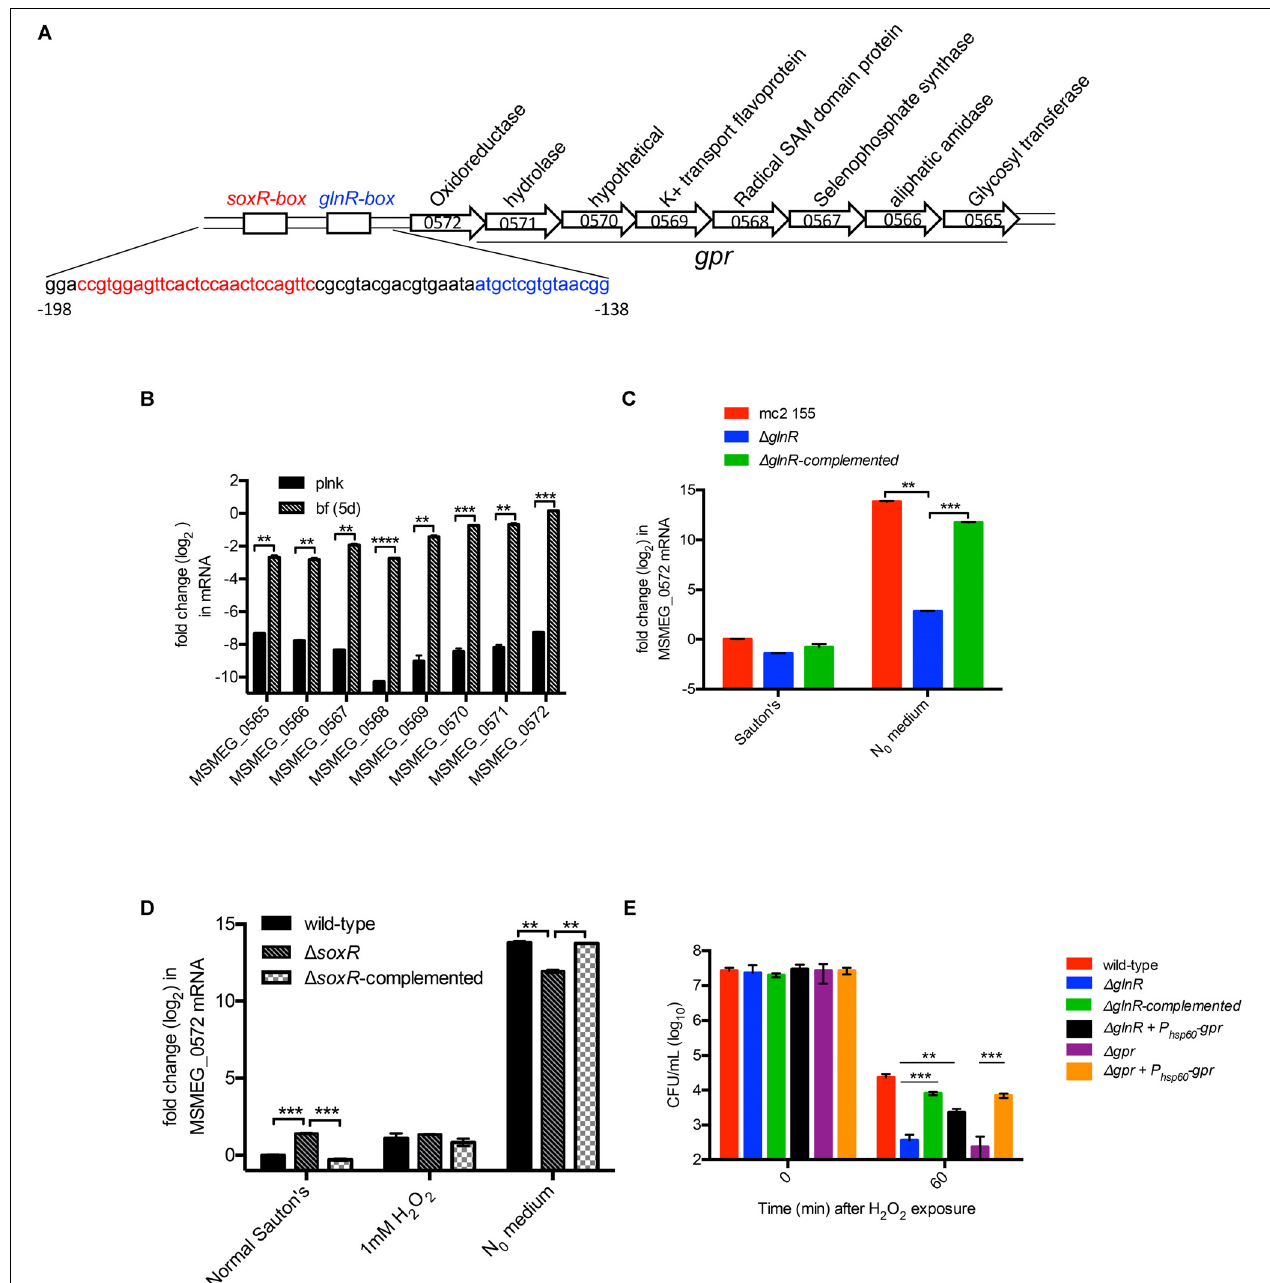
FIGURE 3 | GlnR-dependent peroxide resistance in M. smegmatis results from activation of a cluster comprising of eight genes (MSMEG_0565 to 0572), called gpr . (A) Schematic representation of gpr and the upstream GlnR and SoxR-binding regions, called GlnR -box and SoxR -box, respectively. Nucleotide sequence of the two regions are indicated below in their corresponding color codes. (B) Expression of each of the eight genes in gpr cluster in logarithmic phase (OD 0.3) planktonic culture and in 6-day biofilms, both cultured in Sauton’s medium. Transcripts were normalized with SigA transcripts. (C) GlnR-dependent induced expression of gpr cluster (represented by MSMEG_0572) in N 0 medium. Indicated strains were cultured in normal Sauton’s medium untill OD 0.3 and transferred to N 0 medium for 3 h prior to mRNA analysis by real-time PCR. Cells collected from Sauton’s medium before exposure to N 0 medium were used as reference. Fold-change relative to transcript level in wild-type cells in Sauton’s medium was calculated. (D) Expression of gpr (represented by MSMEG_0572) is unresponsive to SoxR and peroxide in Sauton’s medium. Indicated strains were cultured and processed as described for (C) , except that an additional set exposed to a sub-lethal concentration (1 mM) of H 2 O 2 for 60 min was also included. (E) Expression of gpr is sufficient to restore peroxide resistance in (cid:49) glnR mutant. Viability of the indicated strains before (0 min) and after 30 min of exposure to 20 mM H 2 O 2 . Data in (B–E) represent mean of three biologically independent experiments. ∗∗ and ∗∗∗ indicates p ( t -test) < 0.01 and < 0.001,